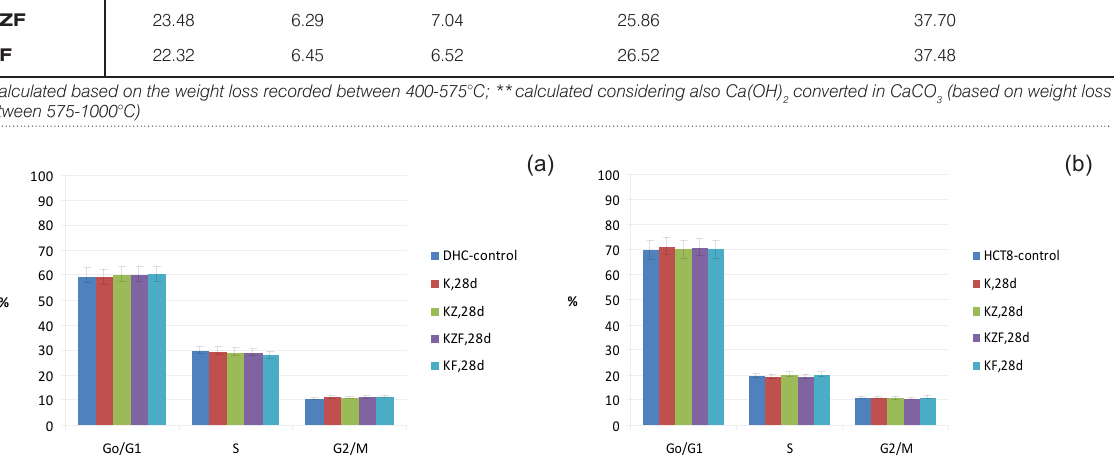
Figure 12. Influence of WMTA (K) and PSC (KZ, KZF and KF) pastes hydrated for 28 days on the cellular cycle phases of: a – DHC; b- HCT 8 cells.